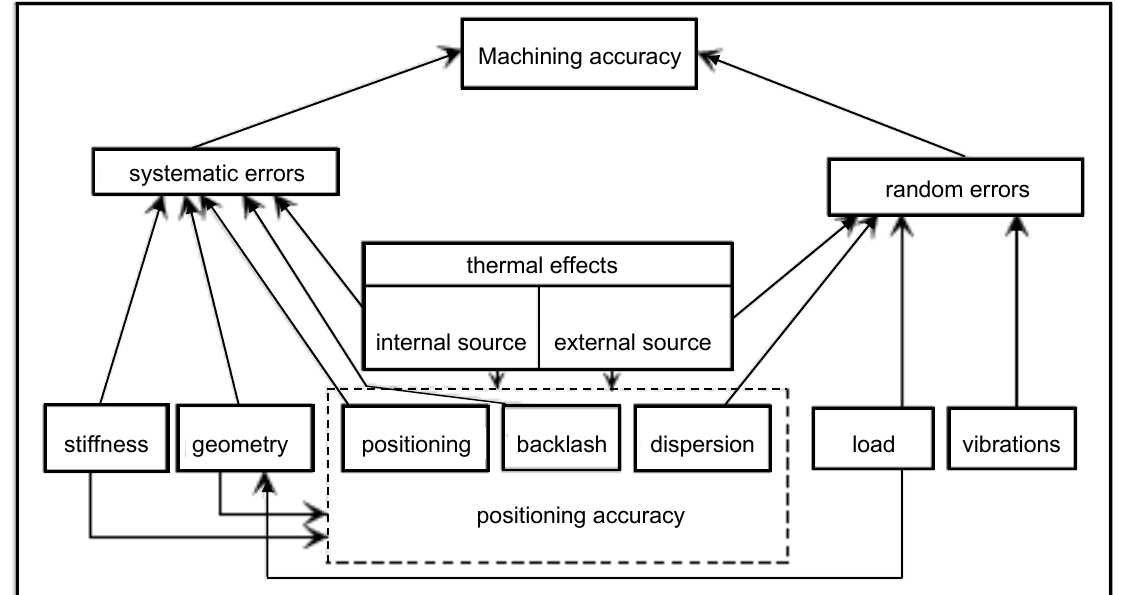
Figure 5. Total error sources of machine tools [40].